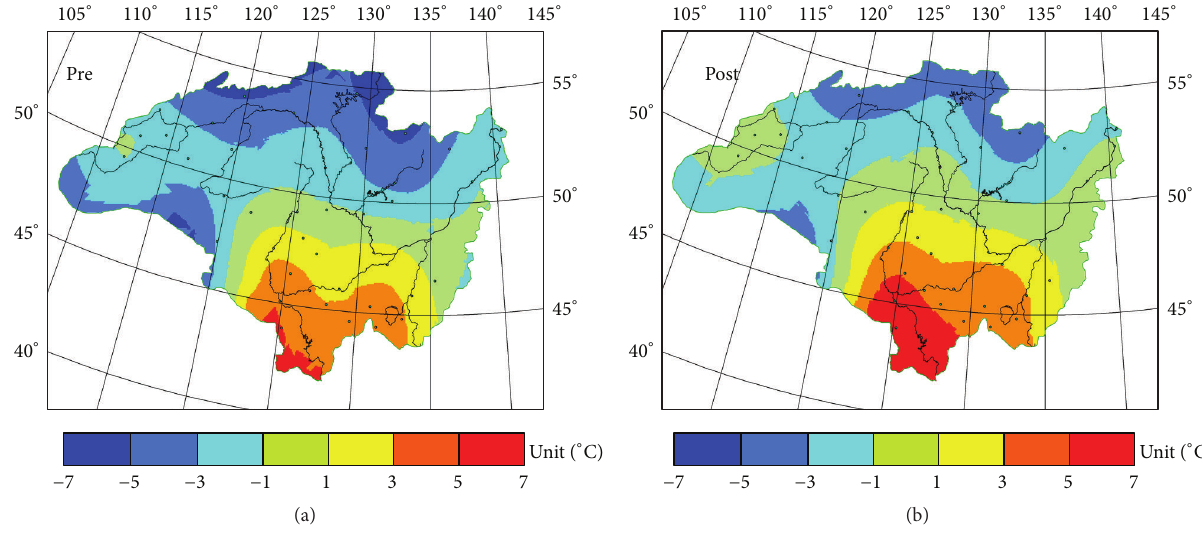
Figure 3: The spatial distribution of the mean value for the pre/postchange point subseries of annual mean temperature.